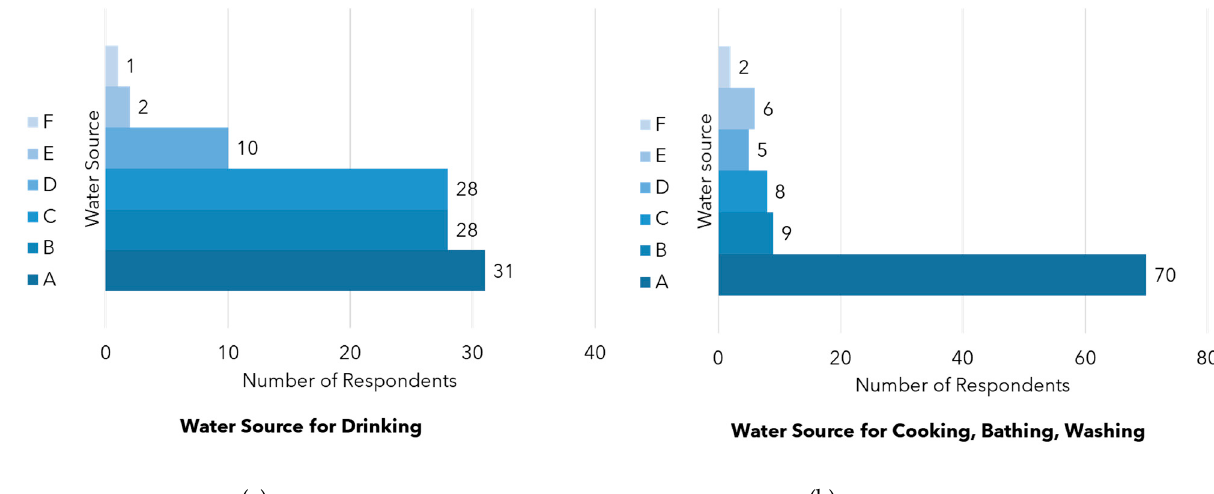
Figure 4. ( a ) Water sources for drinking, where: A. borehole or dug well; B. refill kiosks; C. bottled water; D. bottled water and refill kiosks; E. borehole or dug wells and bottled water; F. borehole or dug well and refill kiosks; ( b ) Water sources for cooking, bathing, and washing, where: A. borehole; B. dug well; C. borehole and bottled water; D. dug well, bottled water, and refill water; E. boreholes and dug well; F. dug well and water vendors; G. borehole and refill kiosks; H. dug well and refill kiosks.